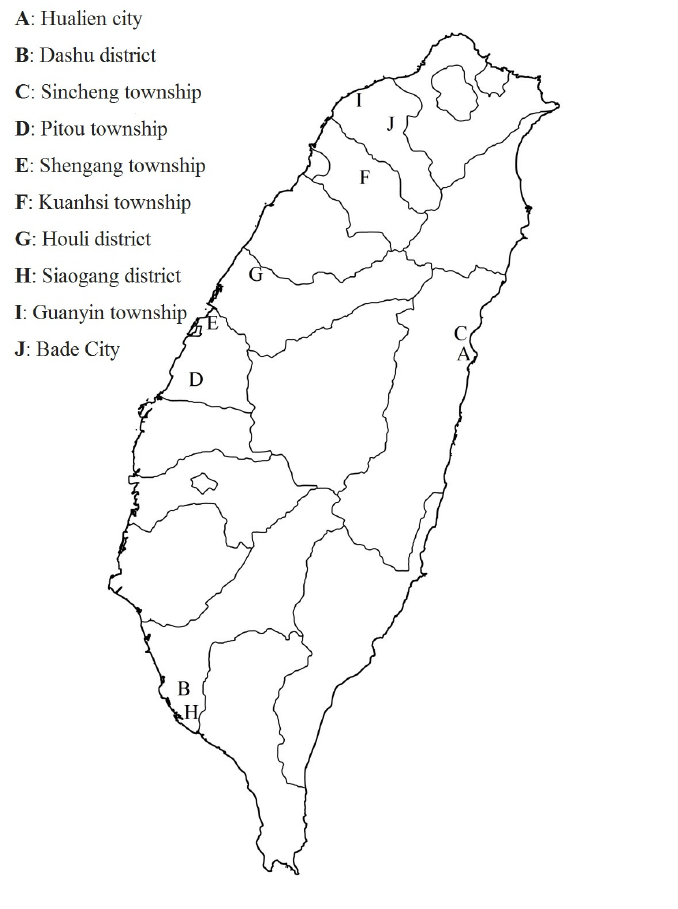
Figure 1. The sampling map of soil dioxin contamination is shown for a national dioxin survey in Taiwan. Soil samples are collected from northern, central, southern, and eastern